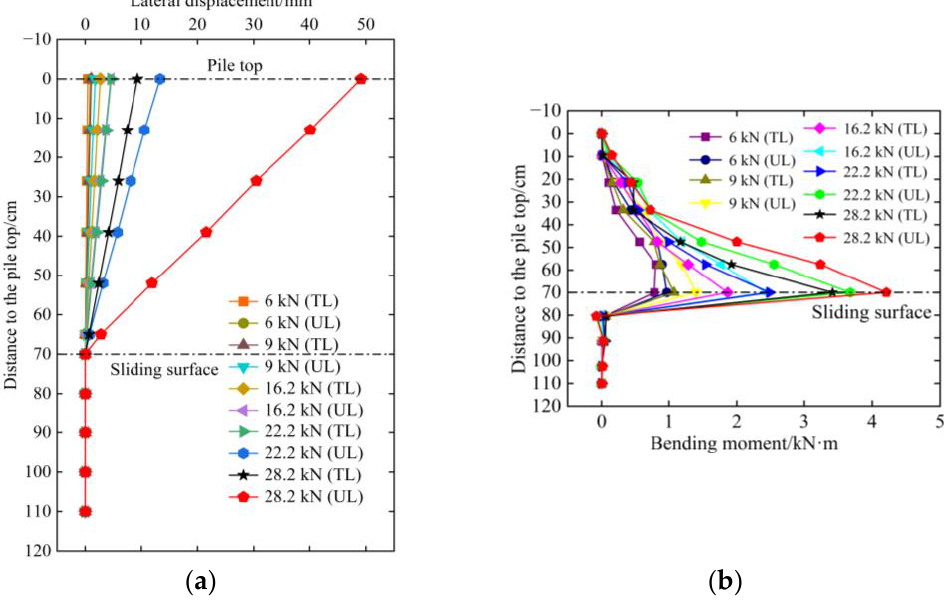
Figure 27. Displacement and bending moment comparisons for the anti-slide pile under trapezoidal load and uniform load. ( a ) Displacement; ( b ) bending